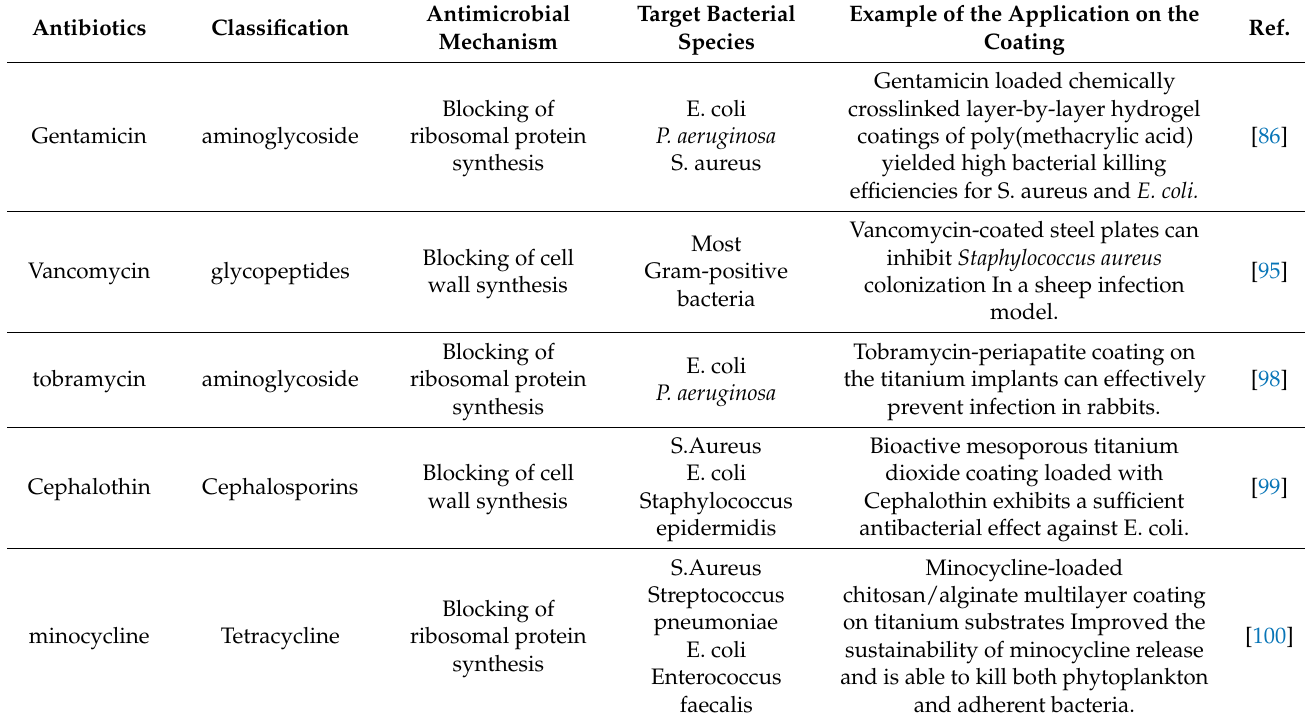
Table 3. Application of antibiotics in the